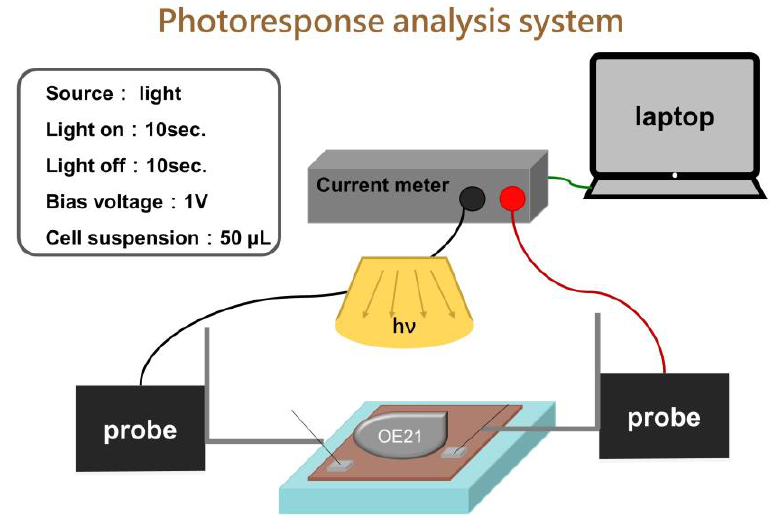
Figure 2. Scheme of the experimental setup used for the photoresponse characterization system. Cells suspension is directly dripped onto 2 × 2 cm 2 biosensor without any immobilization.